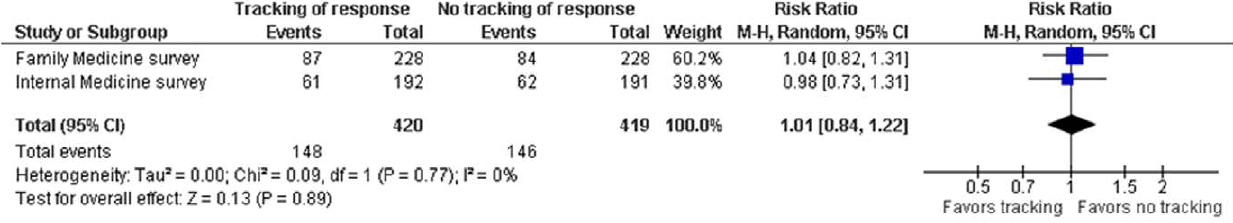
Figure 2. Meta-analysis of response by the time of first reminder comparing tracked vs. non-tracked mailing.